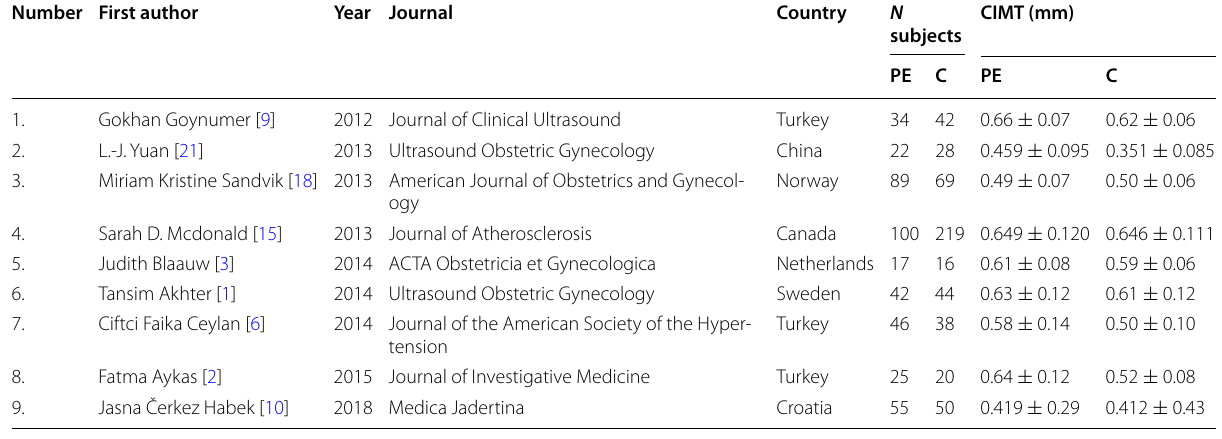
Table 1 Baseline characteristics of studies included in the meta-analysis